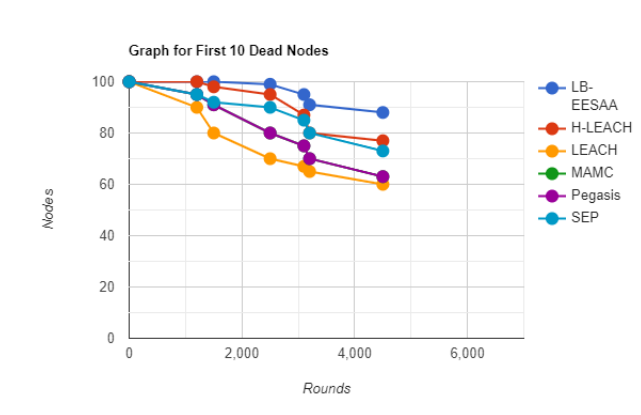
Figure 8. First 10 Dead Nodes